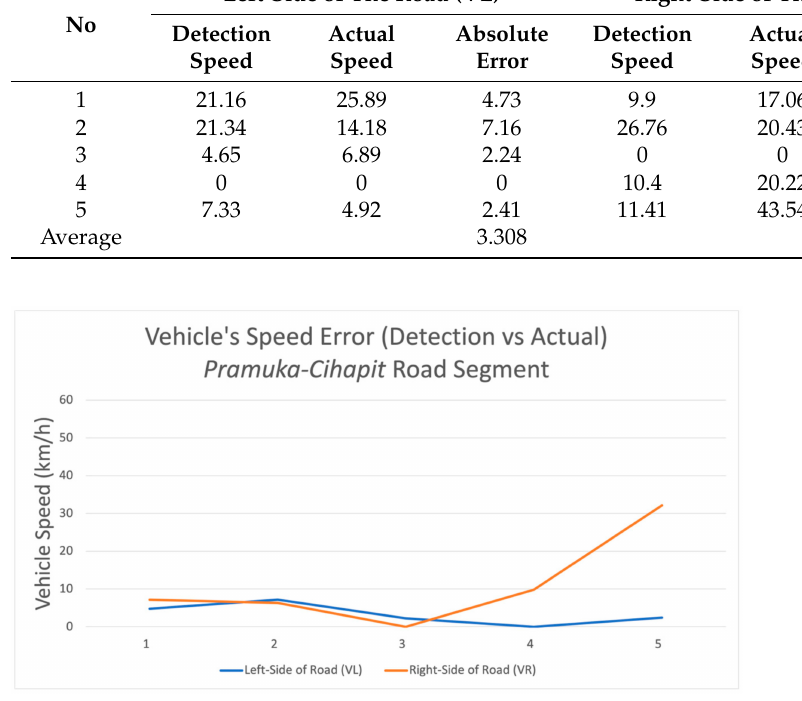
Figure 15. Error rate of vehicle speed calculation on Pramuka–Cihapit road segment. Trunojoyo Road